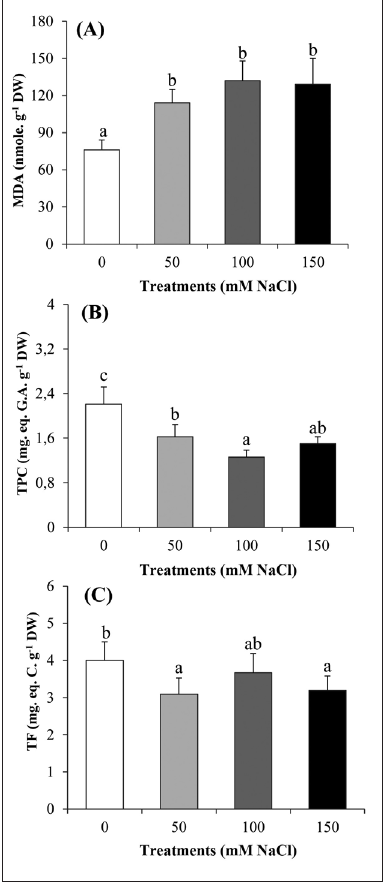
Fig. 5: Oxidative stress marker MDA and chemical antioxidants in C. of- ficinalis after 4 weeks of treatments. (A) Malondialdehyde (MDA), (B) total phenolic compounds (TPC), and (C) total flavonoids (TF). Means with SD (n = 10). Different lowercase letters above the bars indicate significant differences between NaCl treatments according to the Tukey test (α =